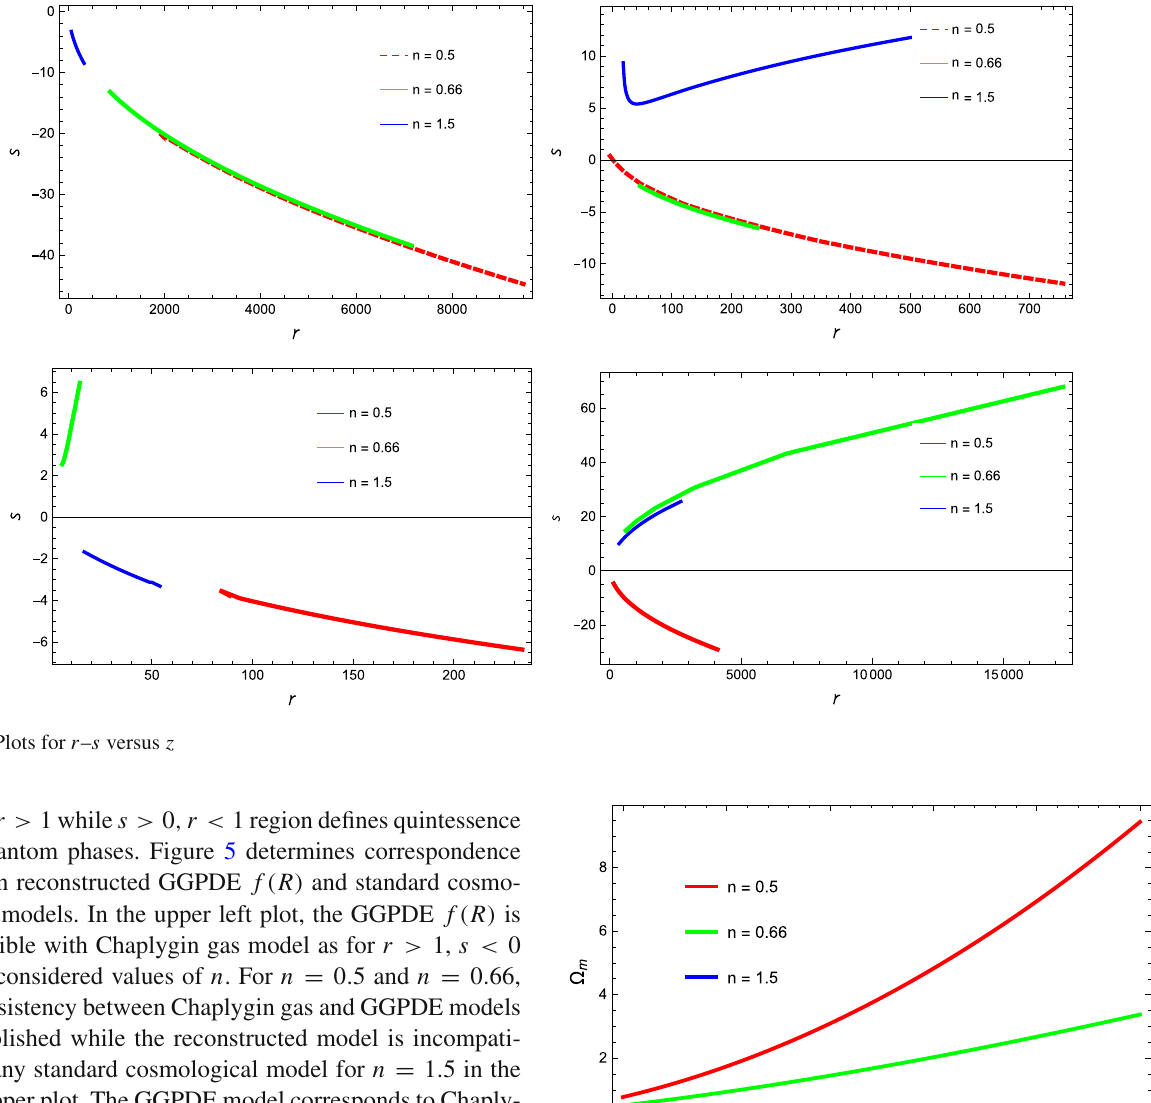
Fig. 6 Evolution of matter density parameter versus z the trajectories of fractional density provide (cid:16) m = 0 . 7, 0 . 5 and 0 . 2 for n = 0 . 5, 0 . 66 and 1 . 5, respectively. In this regard, fractional density parameter of ordinary matter preserves consistency with Planck’s 2018 constraints in the presence of DE. Figure 7 explores the behavior of DE fractional density parameter in the context of closed and open universe mod- els. In the upper plane, the positively increasing curves show that the DE fractional density is consistent with Planck con- straints for n = 0 . 66, 1 . 5 (left plot) while in case of n = 0 . 5, = 0 . 28 implying inconsistent result. In the right plot, the (cid:16) c Planck’s suggested value of (cid:16) c is obtained for all considered values of n . In the lower plane, the compatibility is